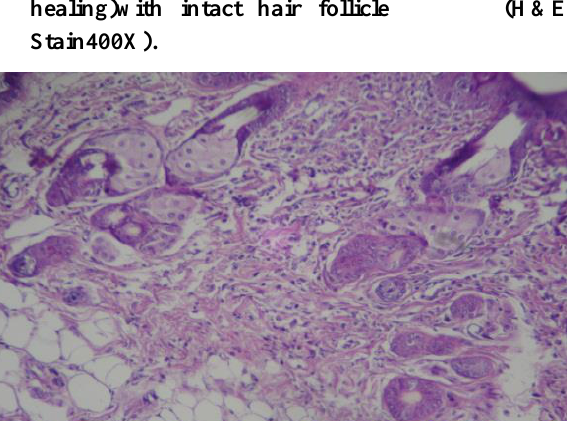
Figure, 14: Section in skin of immunized animal at day 60 post challenge showed mononuclear cells infiltration in dermis and hypodermis with proliferation of collagen fiber in the upper dermis together with vascular dermatitis (H&E Stain 400X).